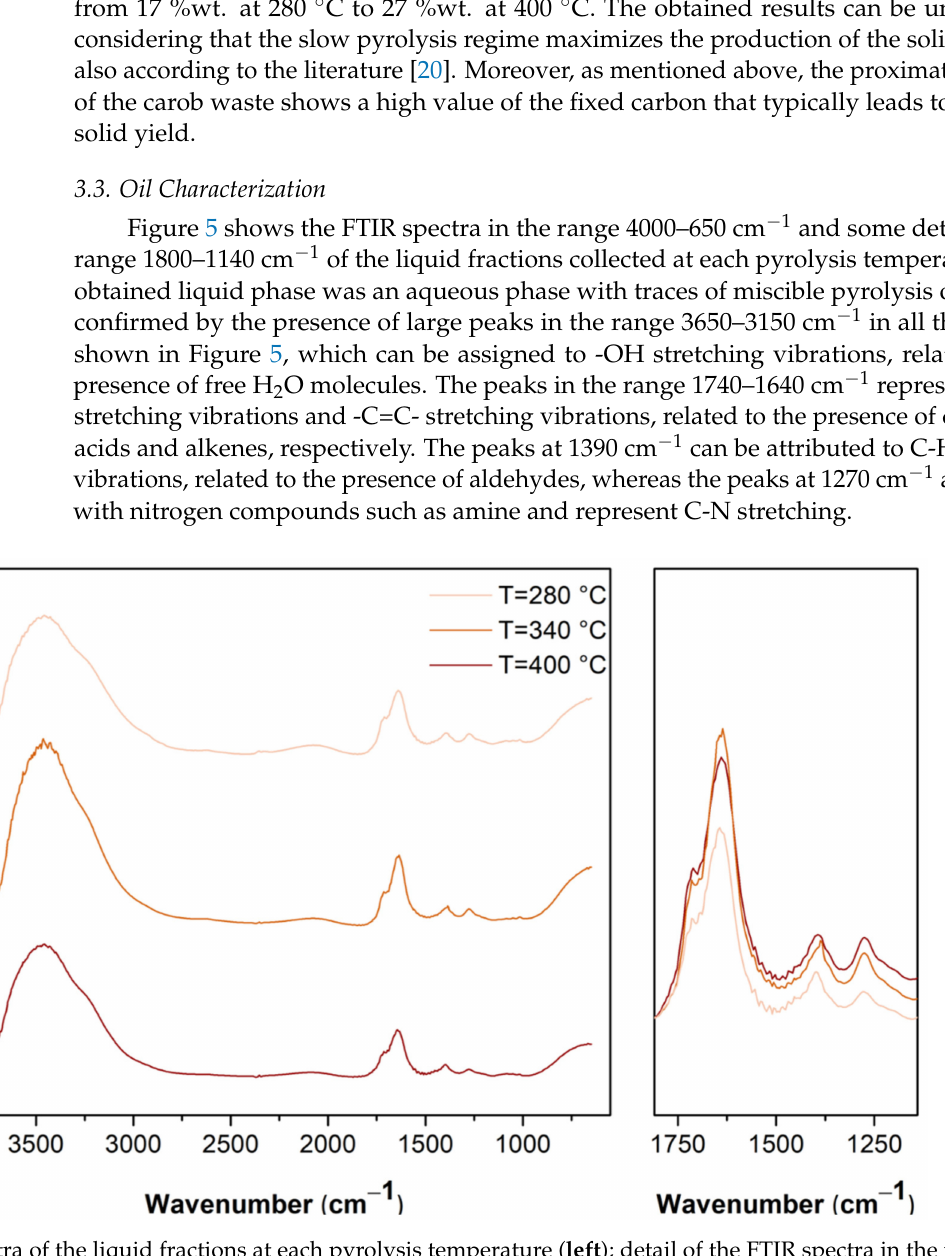
Figure 5. FTIR spectra of the liquid fractions at each pyrolysis temperature ( left ); detail of the FTIR spectra in the range 1800–1140 cm − 1 ( right